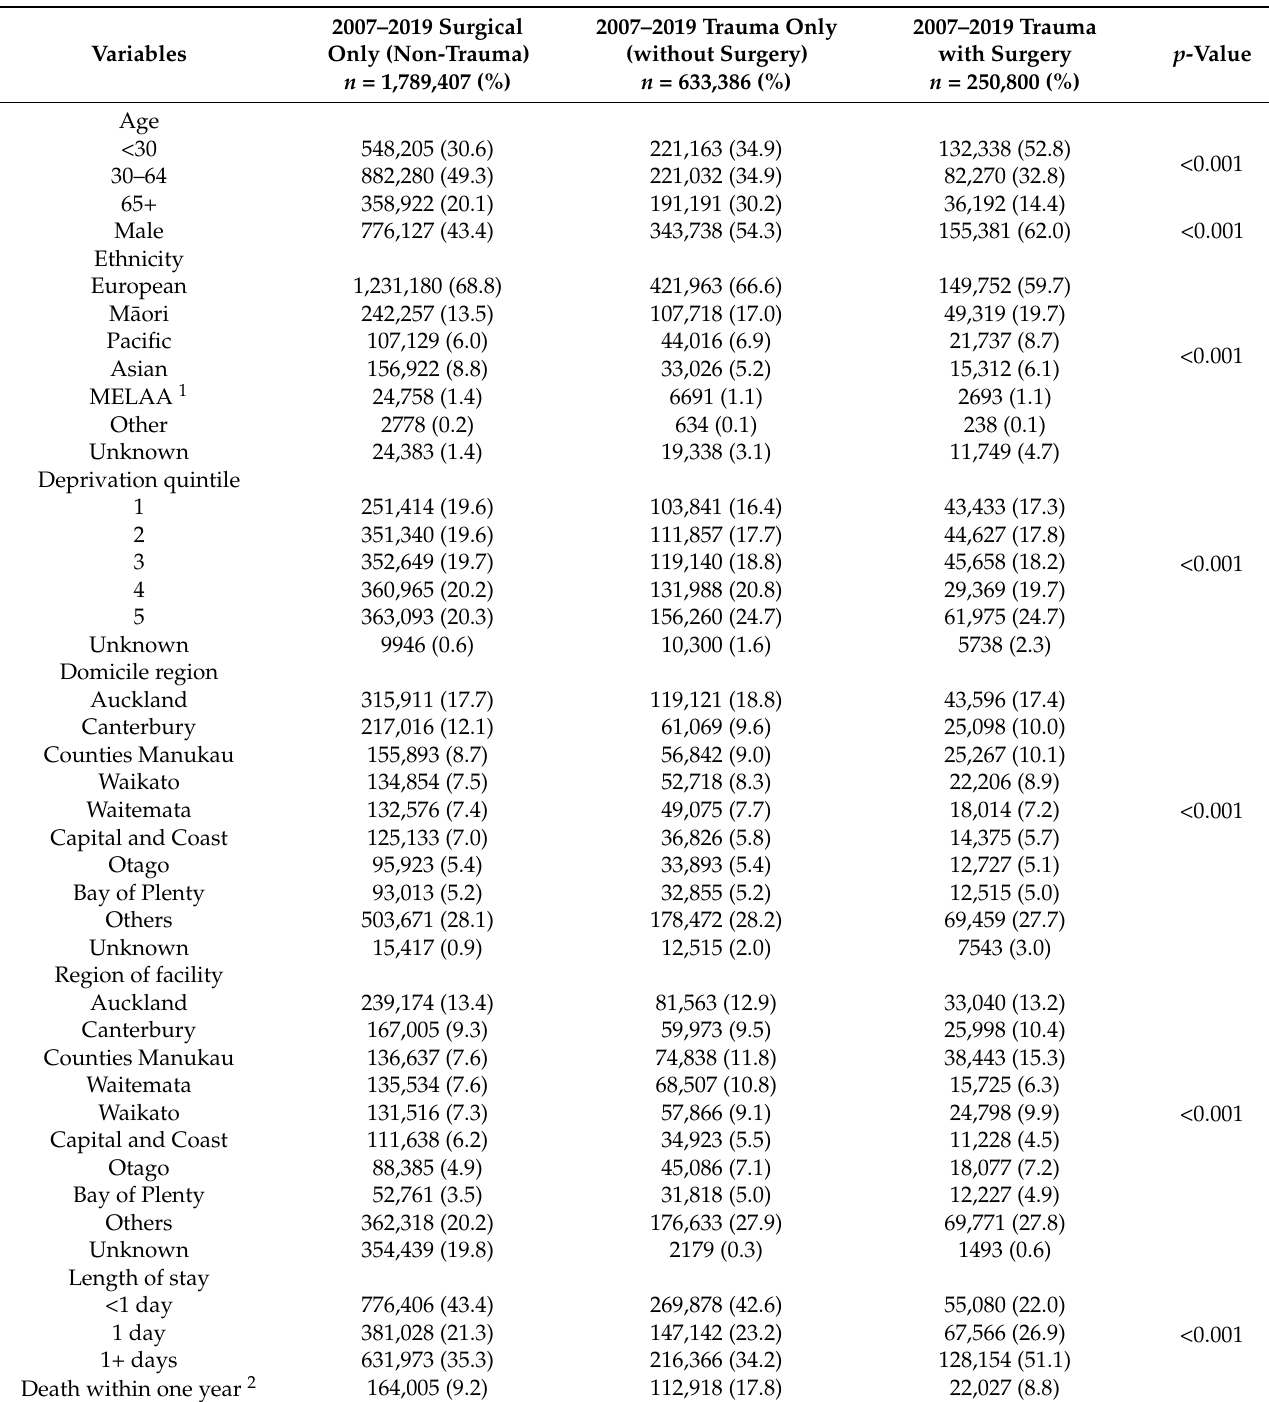
Table 1. Baseline sociodemographic and event